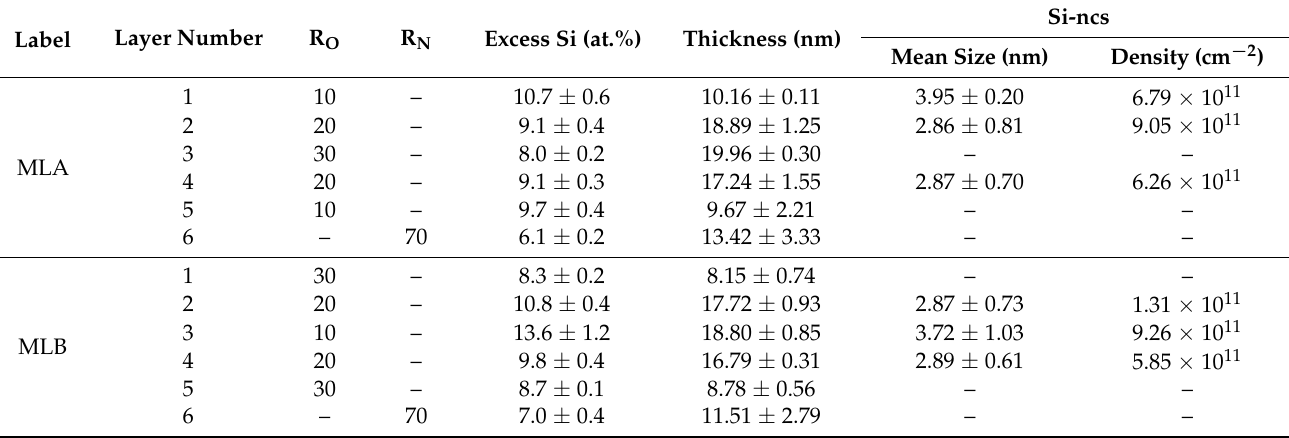
Table 1. Thickness, excess Si, mean size and density of Si-ncs obtained from XPS and HRTEM micrographs for each of the SRO layers.